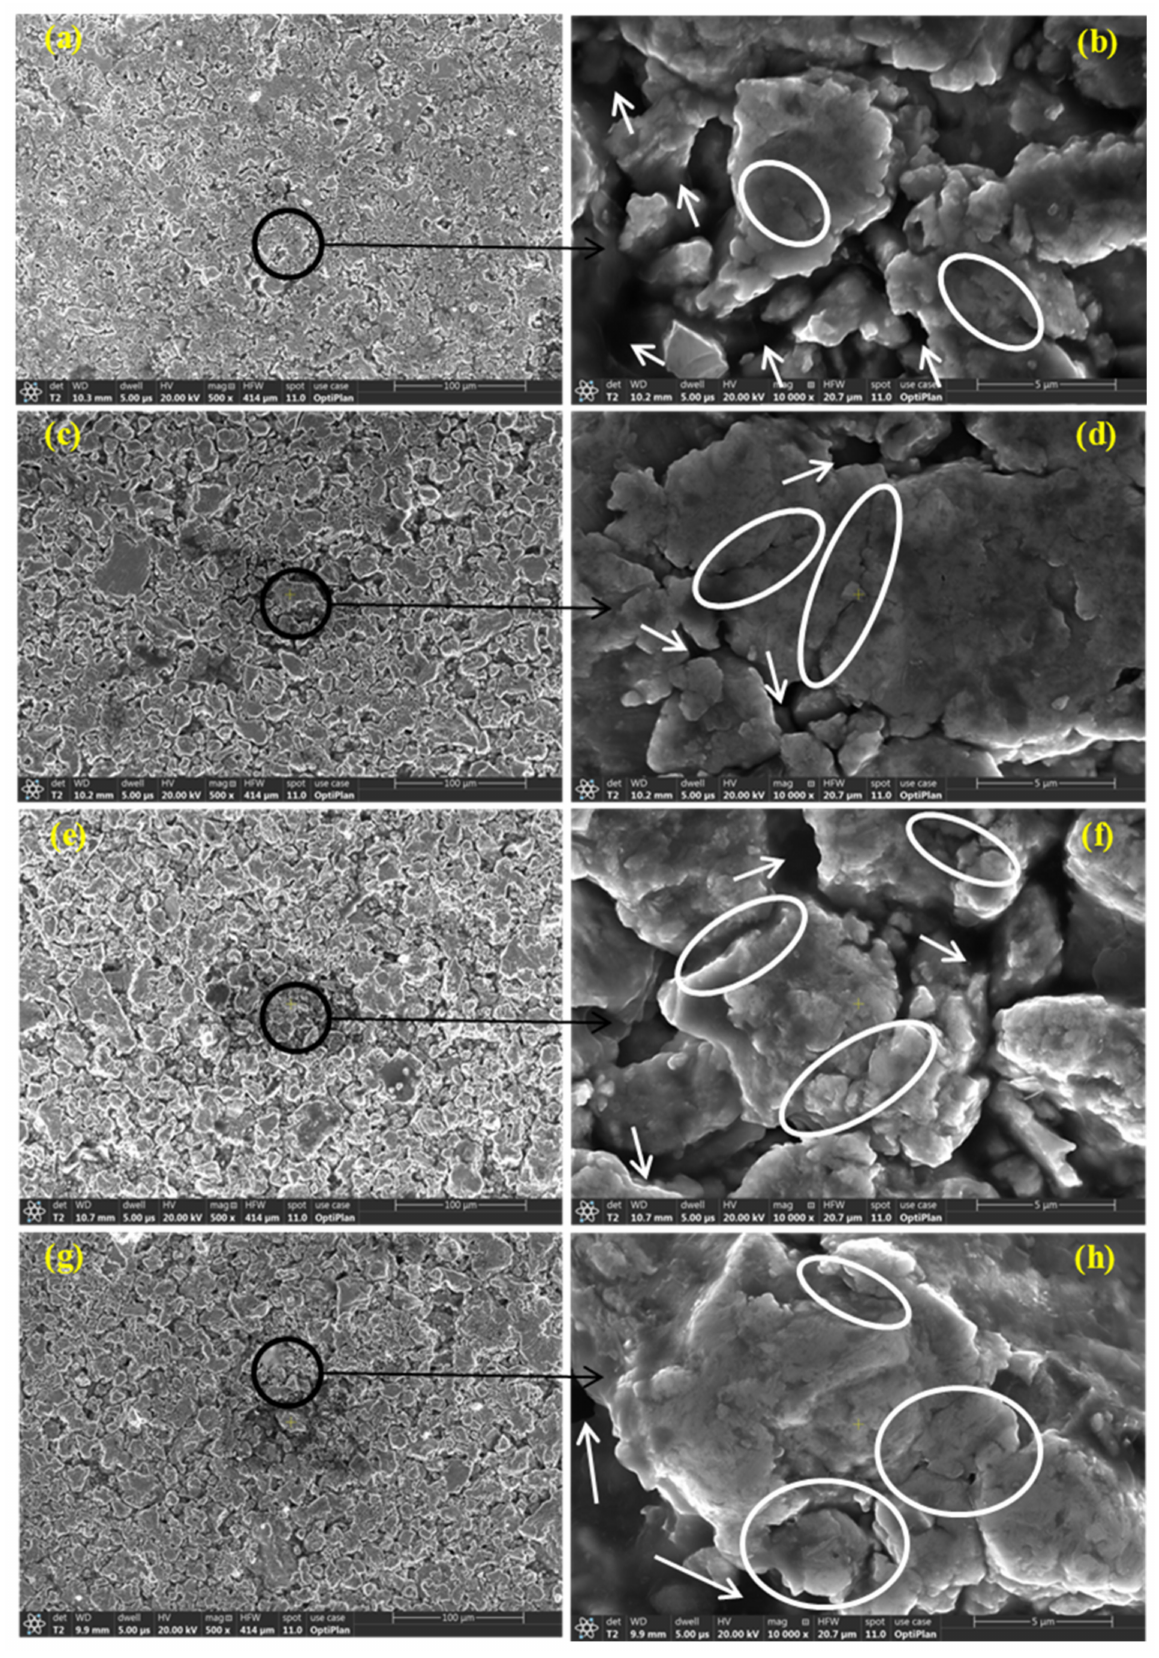
Figure 8. Secondary electron images at low and high magnifications displaying the overview of the green samples: ( a , b ) BM0 alloy; ( c , d ) BM1 alloy; ( e , f ) BM2 alloy; and ( g , h ) BM3